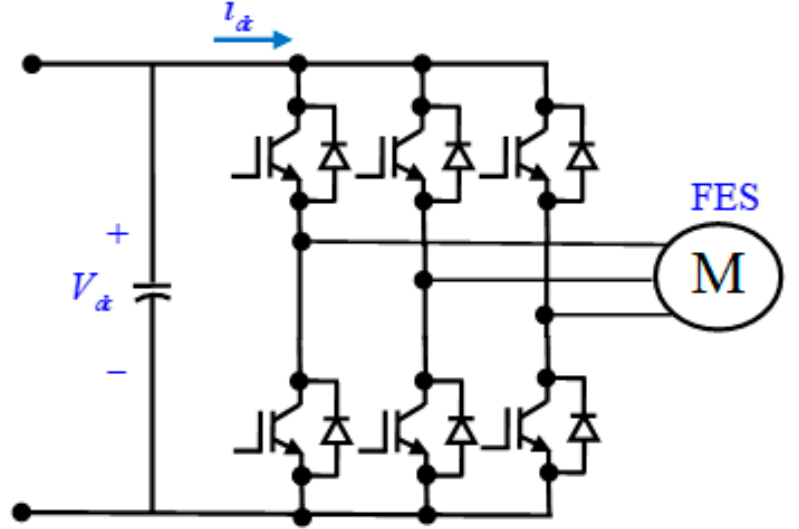
Figure 13. Flywheel system converter.